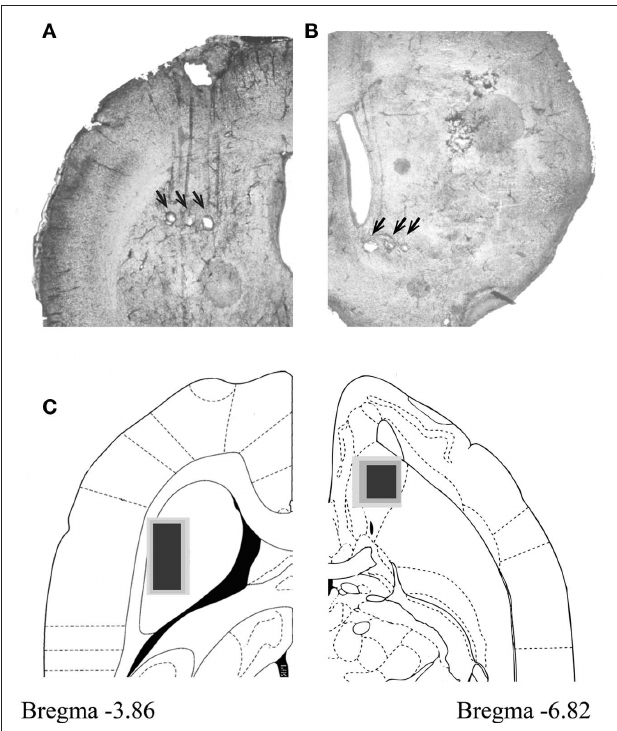
Figure 1 | recording electrodes were positioned in DLS and VS. (A,B) 60 micron sections showing electrode placement in DLS (A) and VS (B) . Location of electrode tips as marked by electrolytic lesions are marked with black arrows. (C) Recording sites marked for all animals in DLS (left) and VS (right). Electrode tip positioning were superimposed on atlas planar sections at depth of − 3.86 (DLS) and 6.82 (VS) from Bregma. Black marks the positioning of about 85% of the electrodes and dark and light gray mark the remaining 10 and